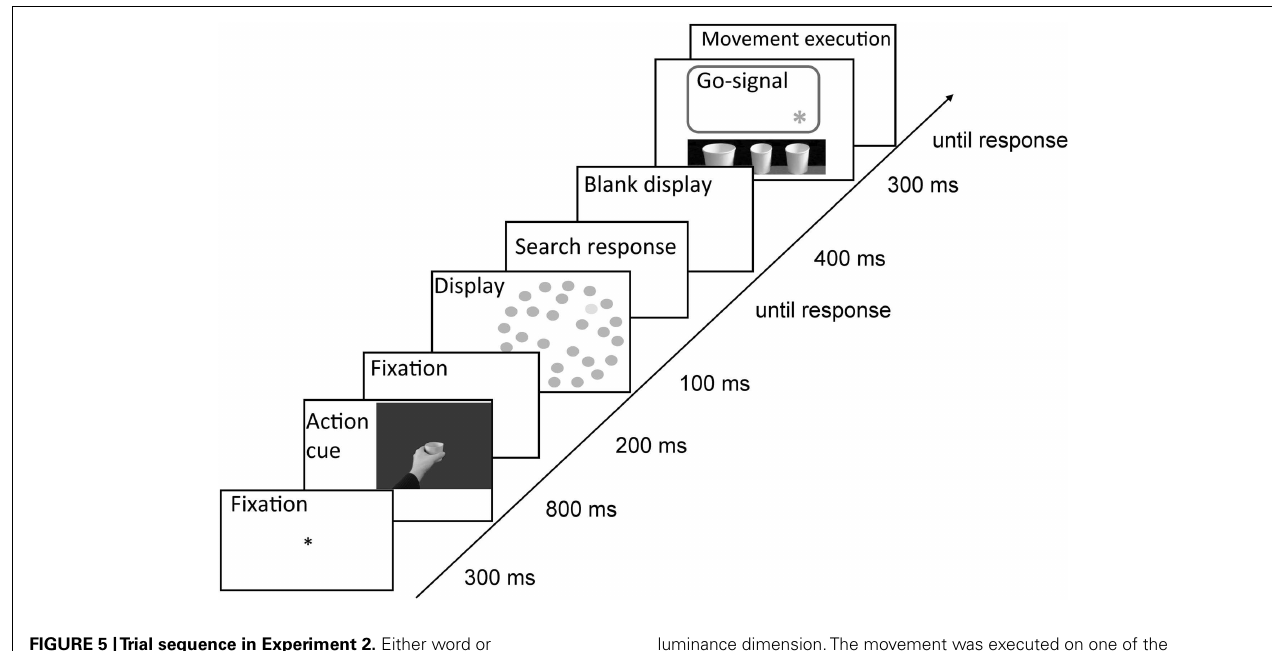
FIGURE 5 |Trial sequence in Experiment 2. Either word or picture cues informed participants about the required action type. Participants always performed the search task first and only then the movement task.Target was defined either by size or